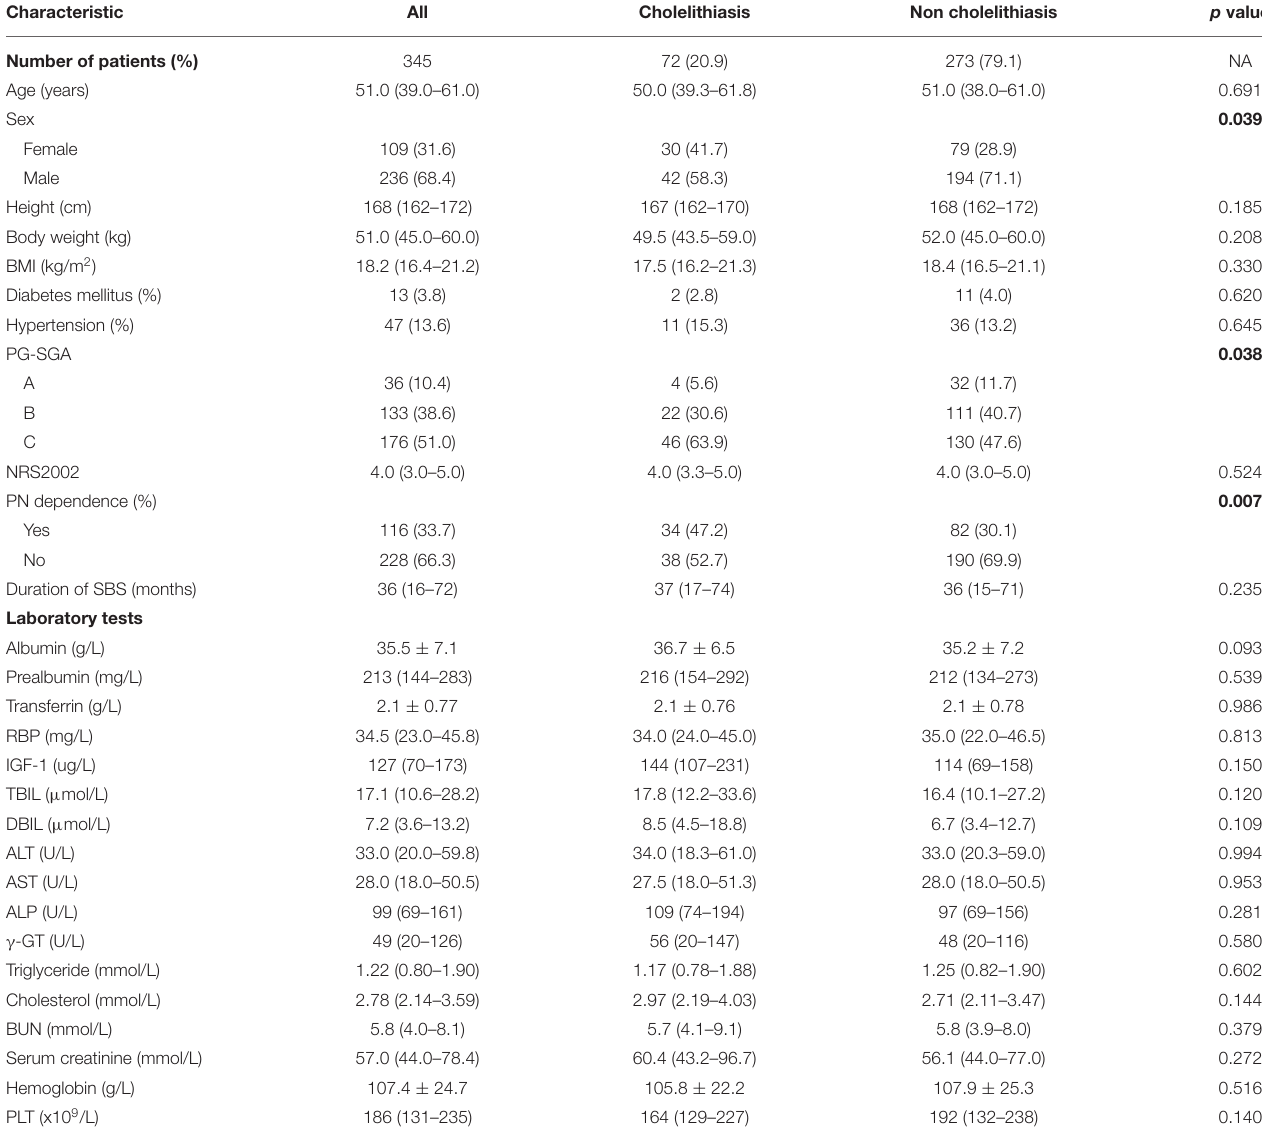
TABLE 1 | Demographic and laboratory tests for the study population. Characteristic All Cholelithiasis Non